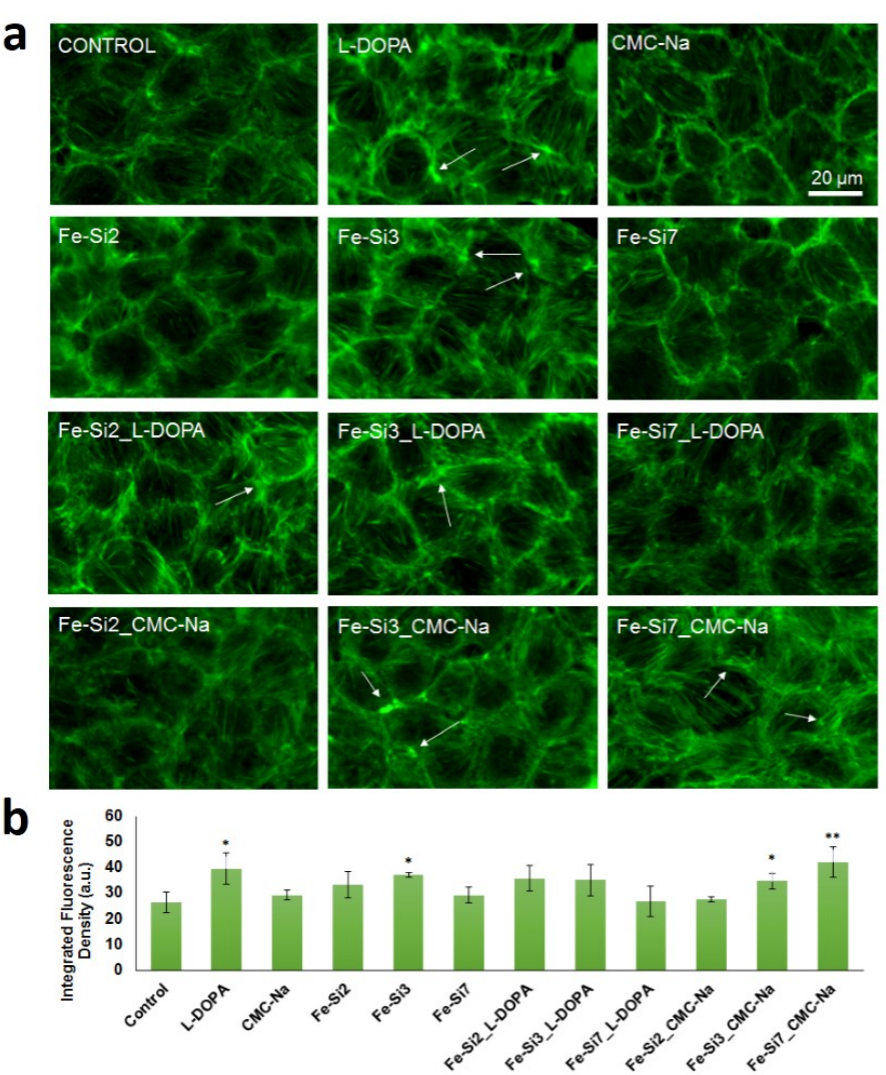
Figure 8. F-actin cytoskeleton in Caco2 cells after exposure for 72 h to 50 µg/mL hybrid Fe-Si NPs. ( a ) Direct immunofluorescence of actin staining by Alexa Fluor 488 phalloidin (green fluorescence). White arrows indicate F-actin aggregation and actin bundles accumulation on cell periphery Magnification: 40×. Control represents untreated cells. Scale bar = 20 µm; ( b ) Quantification of F-actin fluorescence.